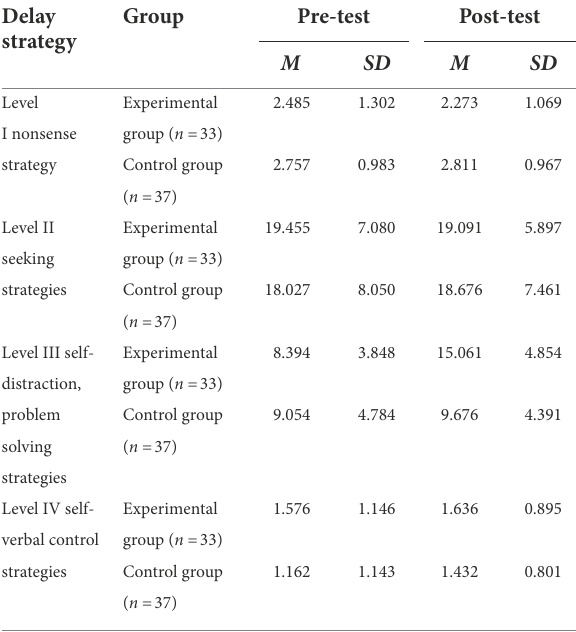
TABLE 5 Descriptive statistical results of delay strategy scores at different levels in children from different groups. Delay strategy